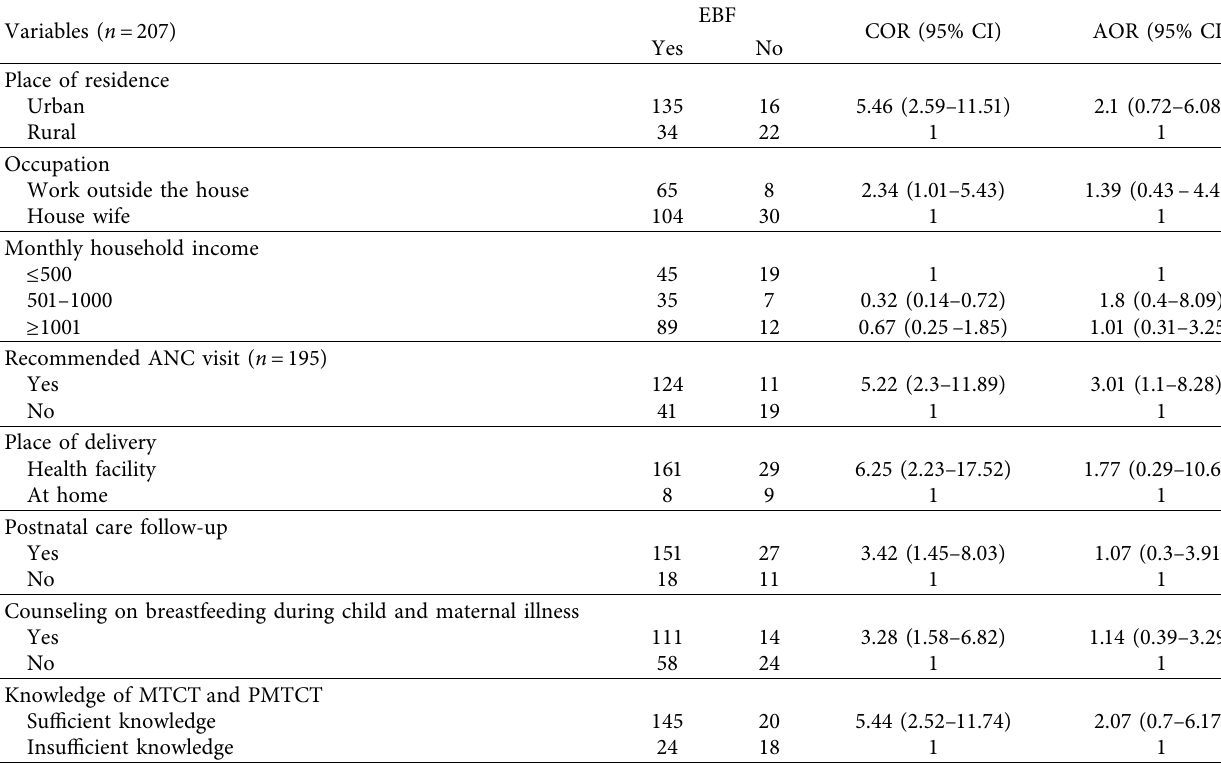
Table 4: Factors associated with EBF practice of mothers with a child under 18 months of age attending in SNNPR, Ethiopia, 2019. Variables ( n �